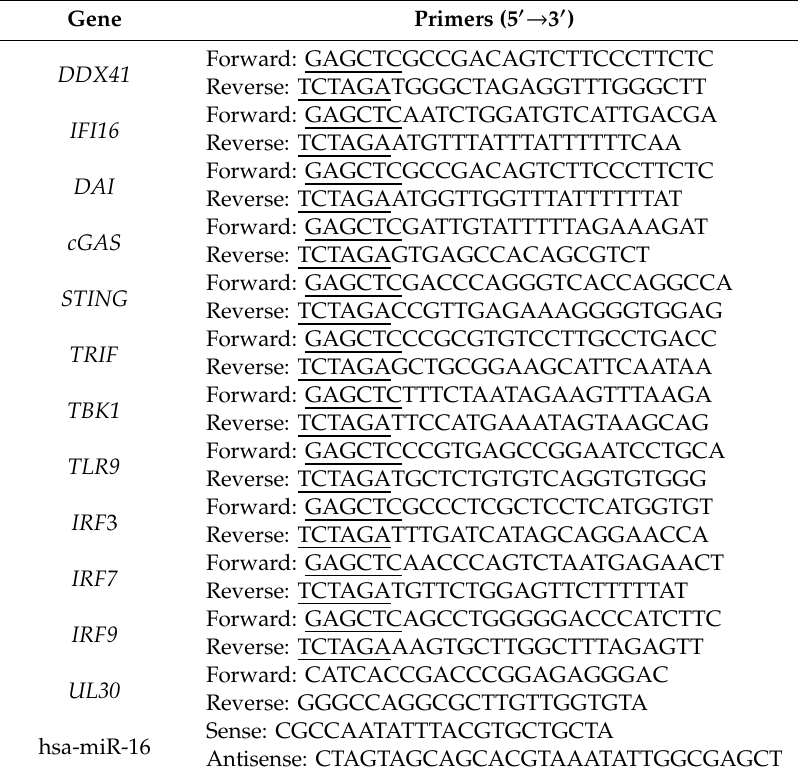
Table 1. Primers used for plasmid